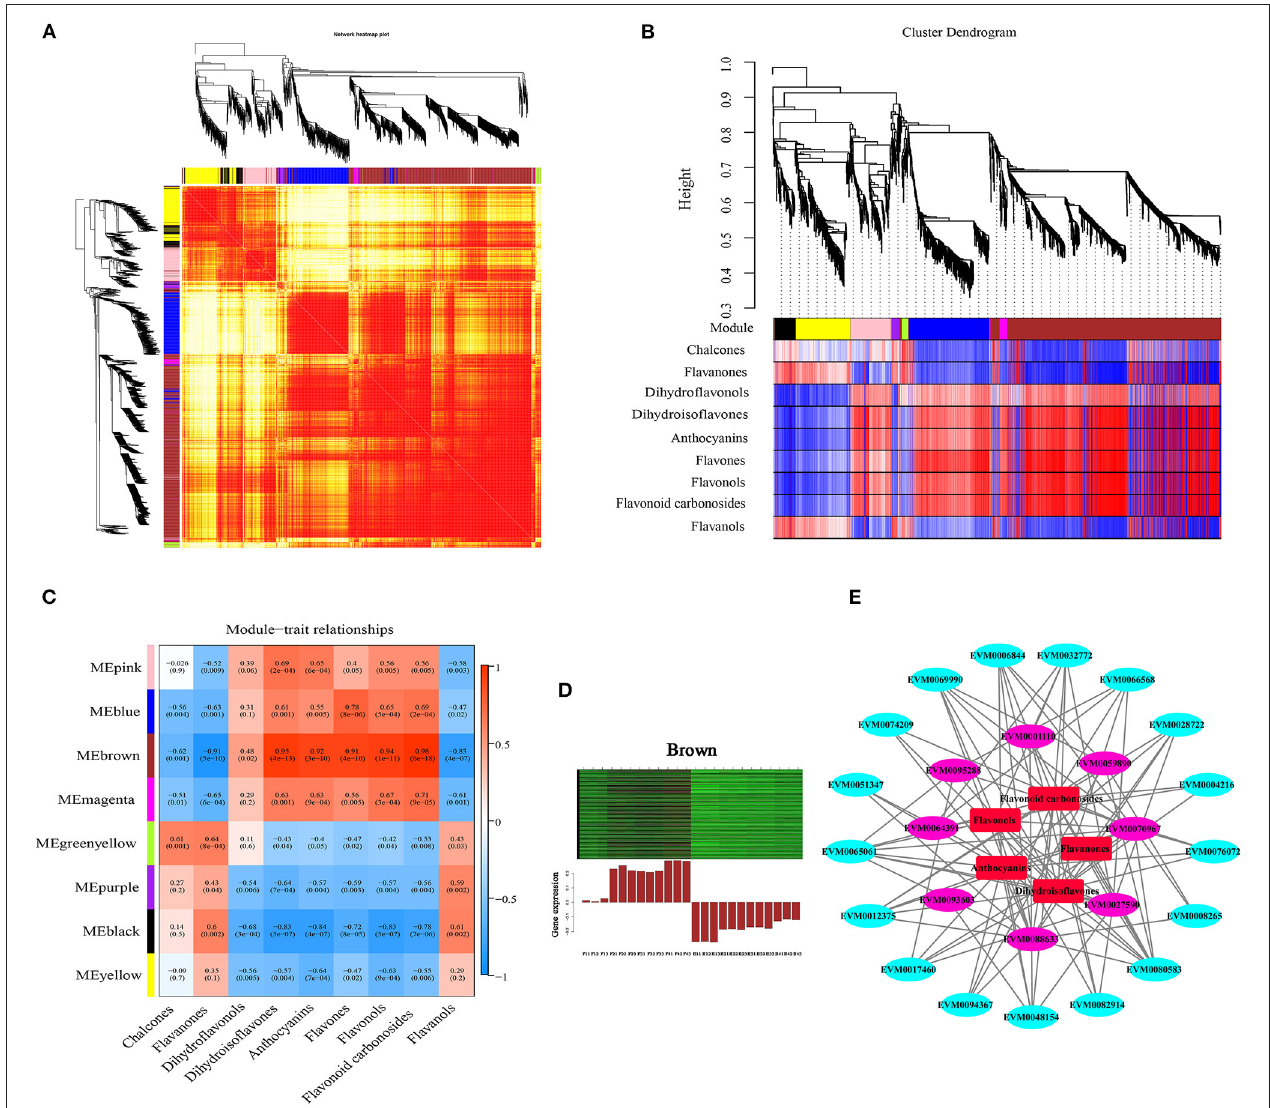
FIGURE 7 | Weighted gene co-expression network analysis of DEGs related to flavonoid content under drought stress. (A) : Network heatmap. (B) : Cluster dendrogram. (C) : Module-trait relationship heat map. Blue indicates low correlation, and red indicates high correlation. (D) : Eigengene expression profile for the brown module in different samples. The heat map above shows the expression profiles of all co-expressed genes in the brown module. The bar graph below shows the common expression patterns of co-expressed genes. (E) : Co-expression network between flavonoid contents and flavonoid-related gene